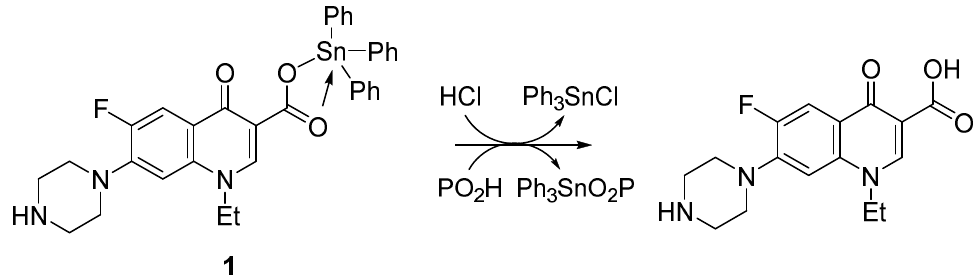
Scheme 3. Complex 1 acts as a hydrogen chloride and peroxide scavenger.